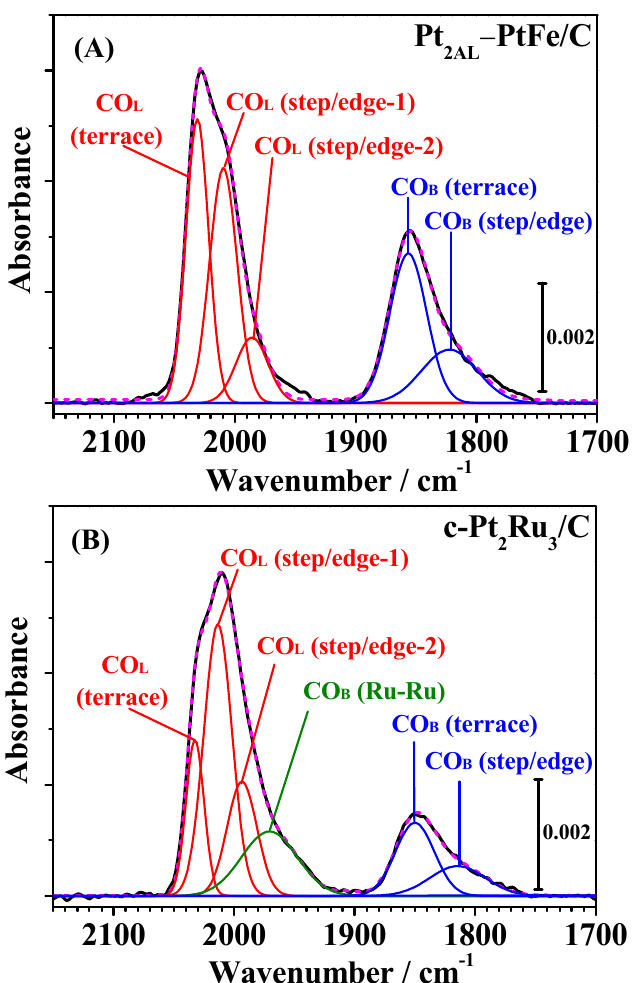
Figure 5. Deconvolution of FTIR spectra observed on ( A ) Pt 2AL –PtFe/C and ( B ) c ‐ Pt 2 Ru 3 /C at 0.02 V and 60 °C after 2 h of 1% CO/H 2 gas bubbling in 0.1 M HClO 4 . The CO L bands in the 2050–1950 cm − 1 region were deconvoluted into three components, which were assigned to CO L on terrace and step/edge sites, respectively. The CO ad bridged on Pt ‐ Ru and/or Ru ‐ Ru sites was approximated by a broad single band with peak at 1967 cm − 1 , which will be denoted as CO ‐ Ru on c ‐ Pt 2 Ru 3 /C. The CO B bands in the 1850–1790 cm − 1 region were also deconvoluted into two components, which were assigned to CO B on terrace and step/edge sites. The experimental spectra in ( A ) and ( B ) were normalized to the total intensities of peaks assigned to CO L , I [CO L ]; ( ‐‐‐‐‐‐‐ ) experimental spectrum, ( ) sum of all peaks, ( ) CO L peaks, ( ) CO ‐ Ru peaks, and ( ) CO B peaks.